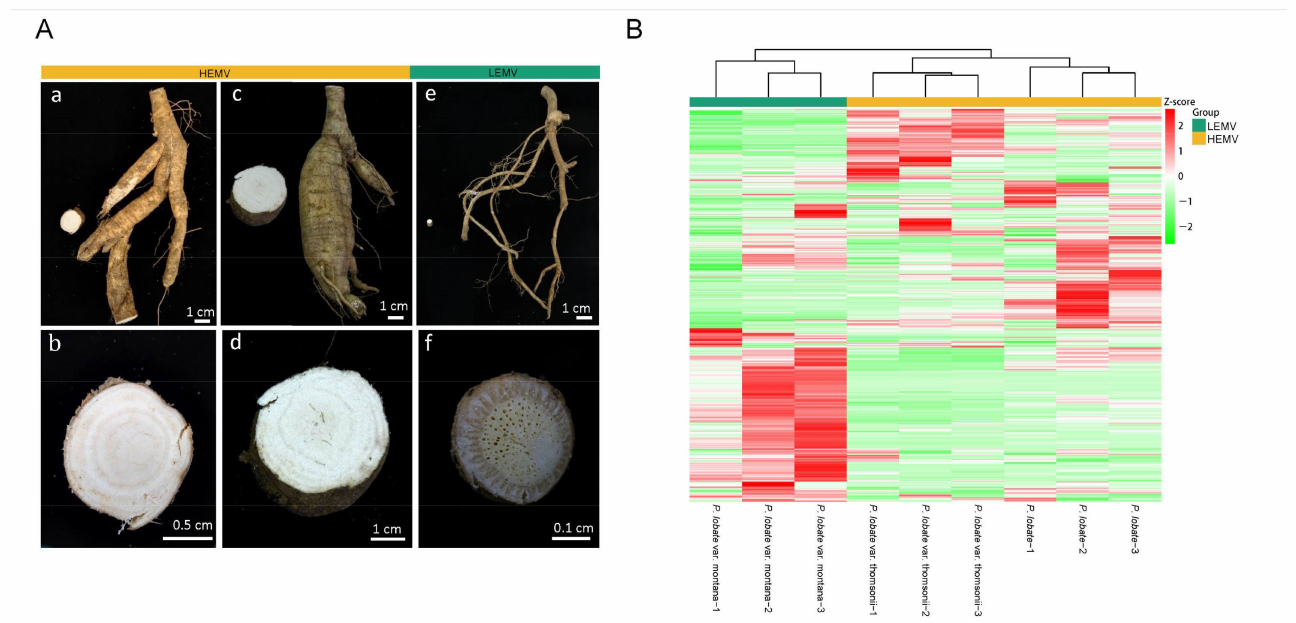
Figure 1. Phenotype of P. lobata and its two varieties. ( A ) One-year-old root tuber of P. lobata ( a , b ), P. lobata var. thomsonii ( c , d ), and P. lobata var. montana ( e , f ). Scale bar = 1 cm. ( B ) Cluster analysis of metabolites from root tuber samples of P. lobata , P. lobata var. thomsonii, and P. lobata var. montana. The color indicates the level of accumulation of each metabolite, from low (green) to high (red). The Z-score represents the deviation from the mean by standard deviation units.